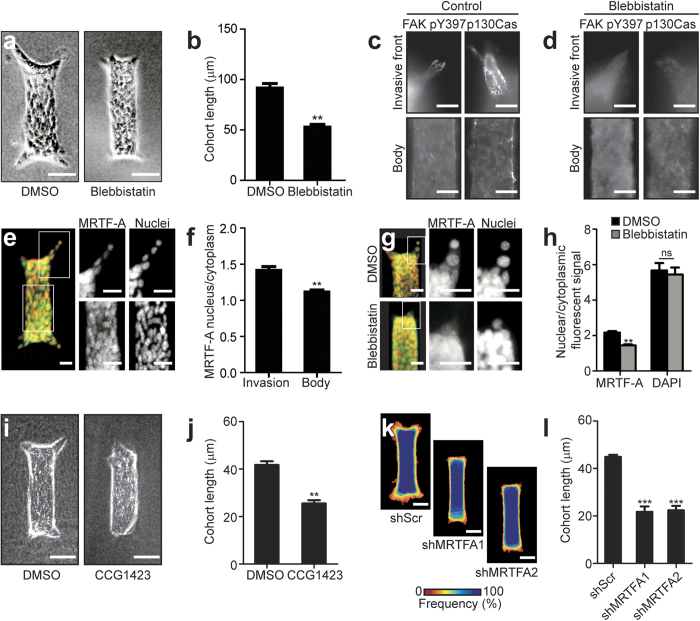
Tensile forces drive collective migration by activating mechanically sensitive intracellular signaling and transcription factors.(a) Phase contrast images showing collective migration from representative tissues treated with DMSO (control) or blebbistatin (12.5 μM). (b) Quantification of cohort length from tissues treated with DMSO or blebbistatin. Mean ± s.e.m. of three replicates is shown, n = 60 tissues per group. **P < 0.01, Student’s t-test. Immunofluorescence staining for FAK pY397 and phospho-p130Cas in representative DMSO (c) and blebbistatin-treated (d) migrating cohorts. (e) Confocal image showing immunofluorescence staining for MRTF-A localization (green) and nuclei (red) in a representative tissue. (f) Quantification of the localization of MRTF-A (nucleus/cytoplasm) in tissues. Levels of nuclear and cytoplasmic MRTF-A were quantified by measuring signal intensity in the two compartments. Mean ± s.e.m. of three replicates is shown. Migrating cohort (invasion): n = 14; quiescent body: n = 11. **P < 0.01, Student’s t-test. (g) Confocal image showing immunofluorescence staining for MRTF-A localization (green) and nuclei (red) in representative tissues treated with DMSO or blebbistatin. (h) Quantification of the localization of MRTF-A (nucleus/cytoplasm) in tissues treated with DMSO or blebbistatin. Levels of nuclear and cytoplasmic MRTF-A were quantified by measuring signal intensity in the two compartments. Mean ± s.e.m. of three replicates is shown. MRTF-A DMSO: n = 29; MRTF-A blebbistatin: n = 21; DAPI DMSO: n = 10; DAPI blebbistatin: n = 12. **P < 0.01, Student’s t-test. (i) Phase contrast images showing collective migration from representative tissues treated with DMSO or CCG-1423 (10 μM). (j) Quantification of cohort length from tissues treated with DMSO or CCG-1423. Mean ± sem. of three replicates is shown. Invading cohorts treated with DMSO: n=80; invading cohorts treated with CCG-1423: n = 57. **P < 0.01, Student’s t-test. (k) Frequency maps showing collective invasion from 34 tissues (three independent replicates) transfected with scrambled shRNA (shScr) or shMRTF-A (two constructs). (l) Quantification of cohort length from tissues transfected with shScr or shMRTF-A. Mean ± s.e.m. of three replicates is shown, n = 50 tissues per group. ***P < 0.001, Student’s t-test. All images are representative of three independent replicates in which >50 tissues were monitored. Scale bars, 50 μm (a,i,k), 25 μm (c,d,e,g).